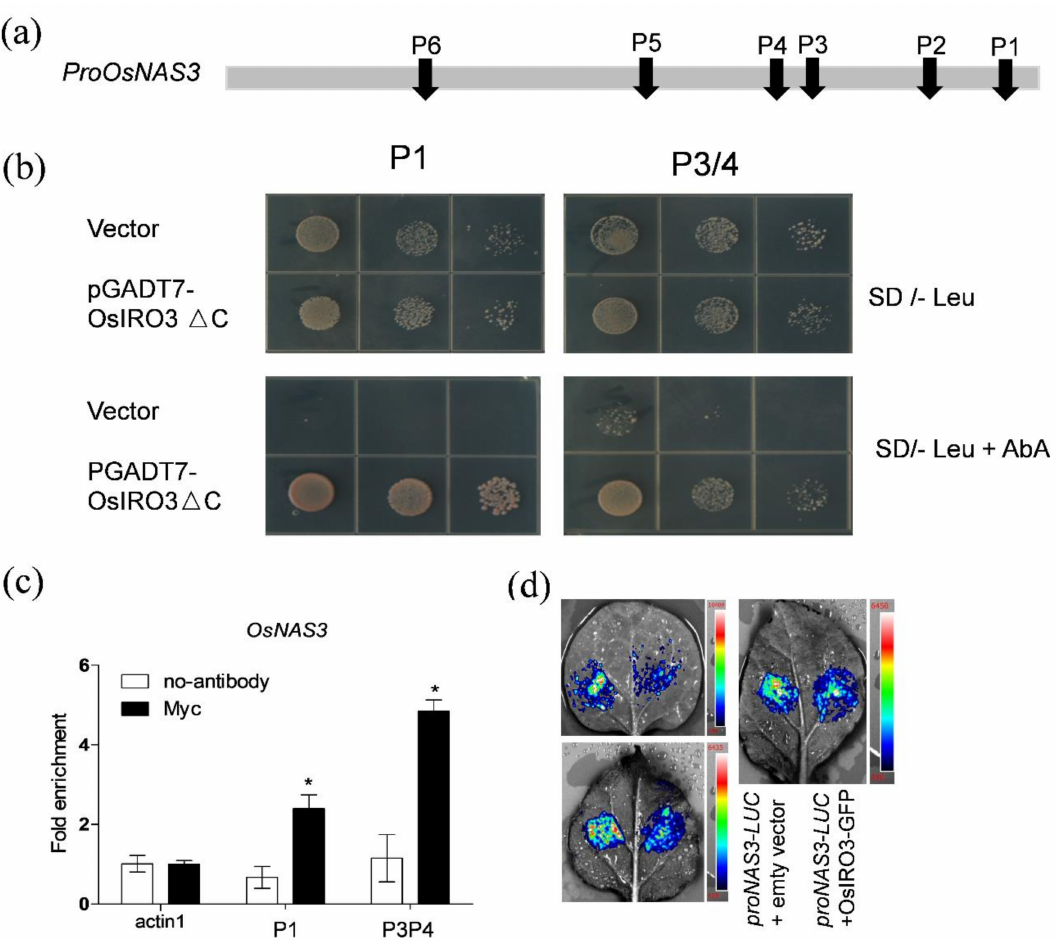
Figure 6. OsIRO3 binds to the promoters of OsNAS3 . ( a ) E-boxes in the promoter. The bar indicates the position of the E-box in the 1 kb sequence from the translation start site of OsNAS3 . ( b ) Yeast-one-hybrid assays. The P1 and P3 / 4 sequence indicated in ( a ) were used as bait and OsIRO3 as prey. The representative growth status of yeast cells is shown on synthetic dextrose medium agar plates without Leu (SD / -Leu) with or without aureobasidin A (AbA). The AbA resistance was activated by prey proteins that specifically interact with the bait sequence. ( c ) ChIP-qPCR analyses of the DNA binding ratio of OsIRO3 to the promoters of OsNAS3 . qPCR was used to quantify enrichment of the indicated promoters and a fragment of the OsActin1 promoter containing an E-box motif was used as a negative control. The DNA binding ratio indicates the targeted DNA fragment levels relative to the OsActin1 promoter fragment. Data are given as the means ± SD of three biological replicates. Significant di ff erences from control (no-antibody) are indicated by * p < 0.05, as determined by two-tailed Student’s t test. ( d ) OsIRO3 repressed the activity of the OsNAS3 promoter in transient expression assays. The three pictures are representative of three experiments, respectively. The left side of tabaco leaves were co-expressed ProOsNAS3 -LUC and empty vector, the right side of tabaco leaves were co-expressed ProOsNAS3 -LUC and OsIRO3-GFP. In the color scale, “Red” represents a high LUC signal, while the color “Blue” represents the lowest LUC